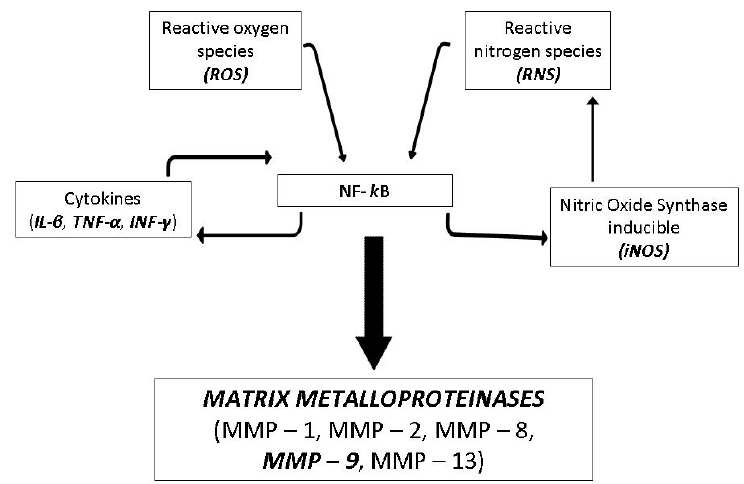
Figure 1. MMPs activation via oxygen and nitrite (ROS and RNS) radicals, pro-inflammatory cytokines and growth factors) and inducible nitric oxide synthase (iNOS).